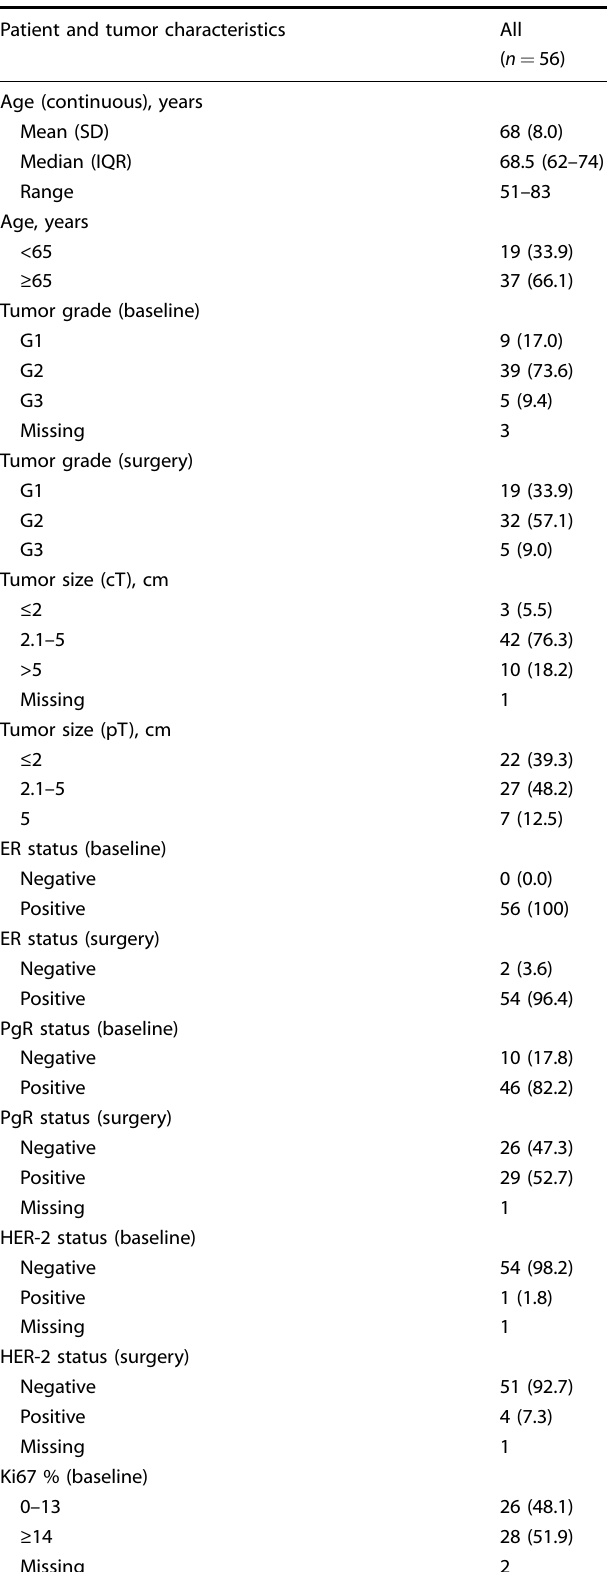
Table 1. Patient and tumor characteristics according to BMI category. Patient and tumor